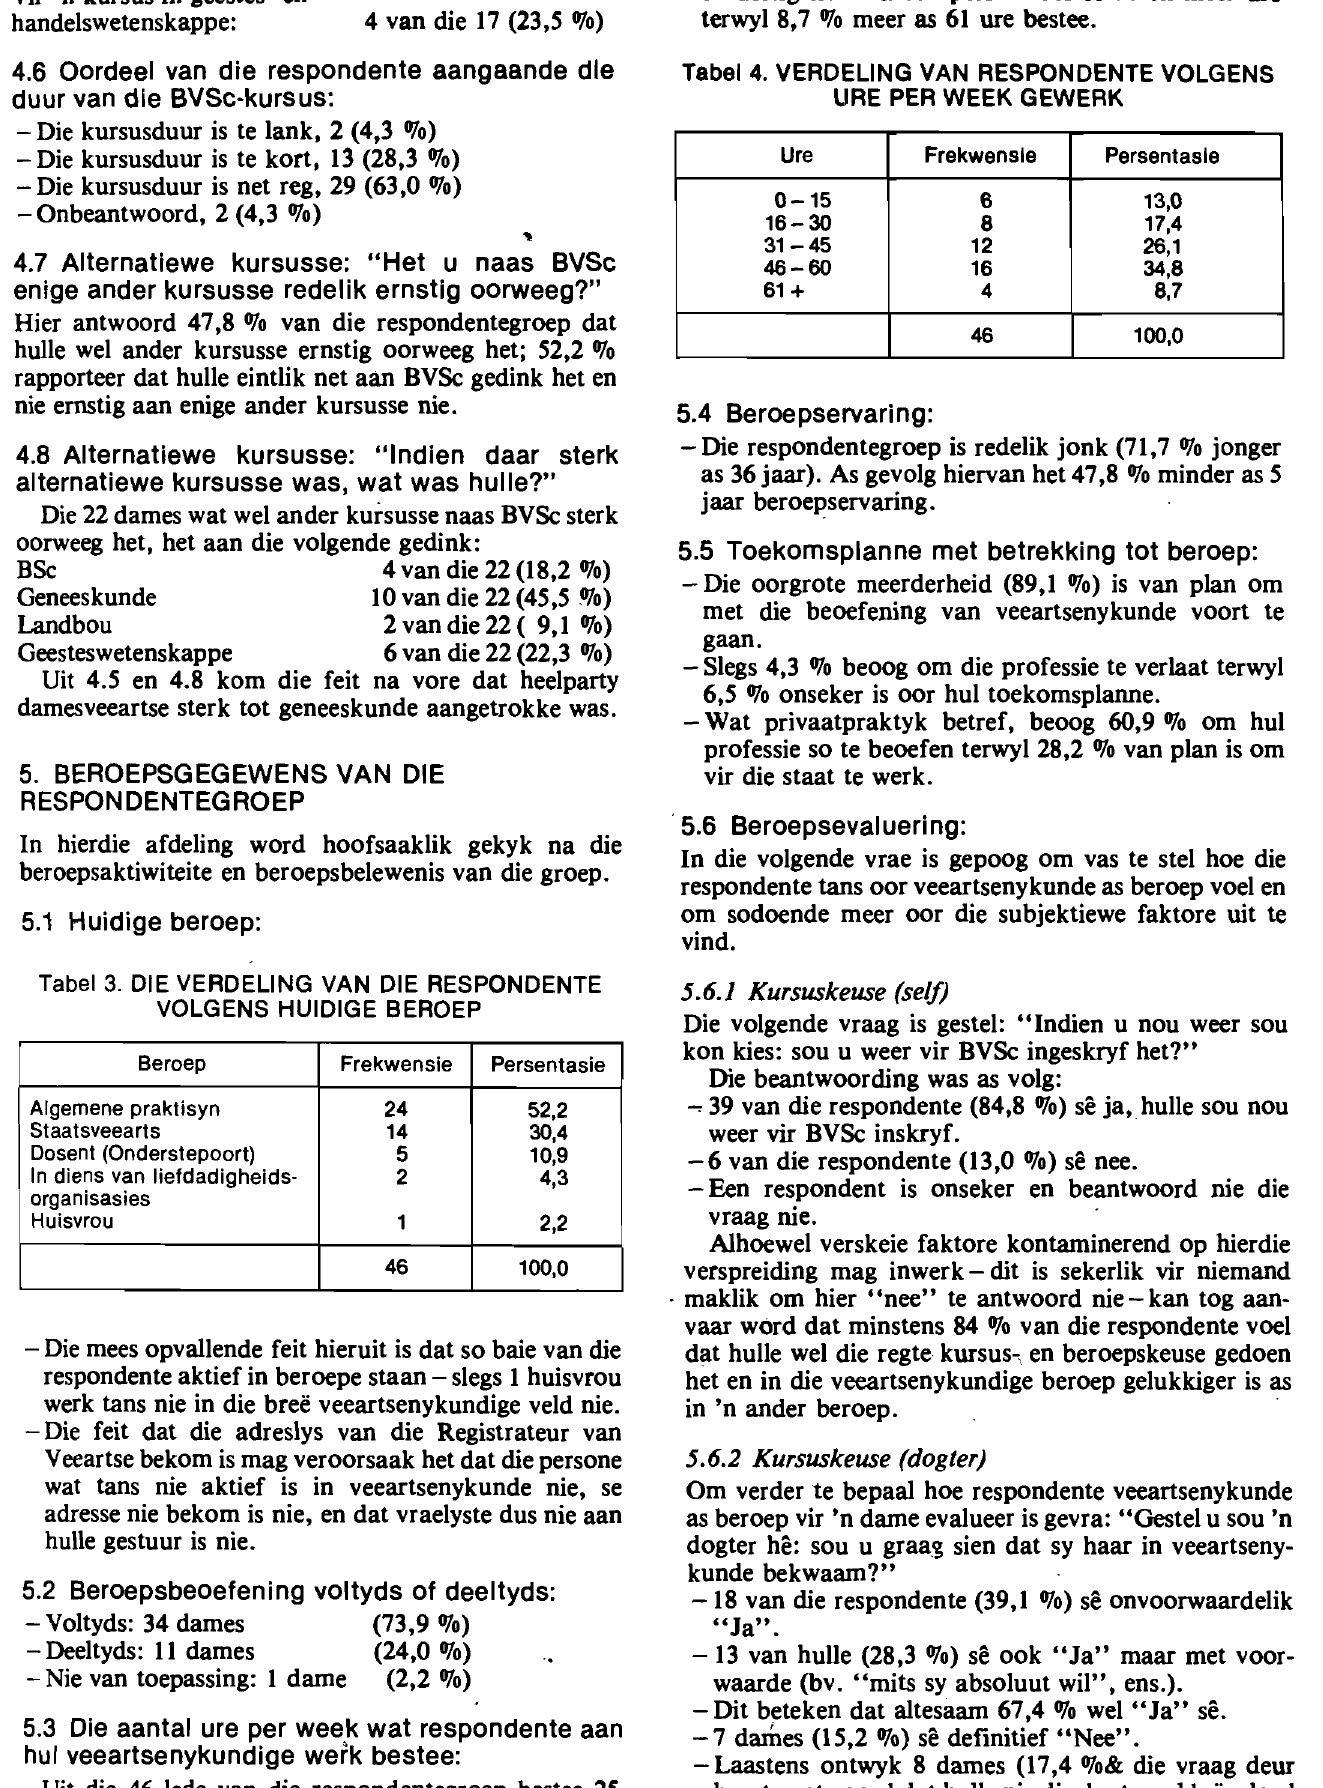
Tabel 3. DIE VERDELING VAN DIE